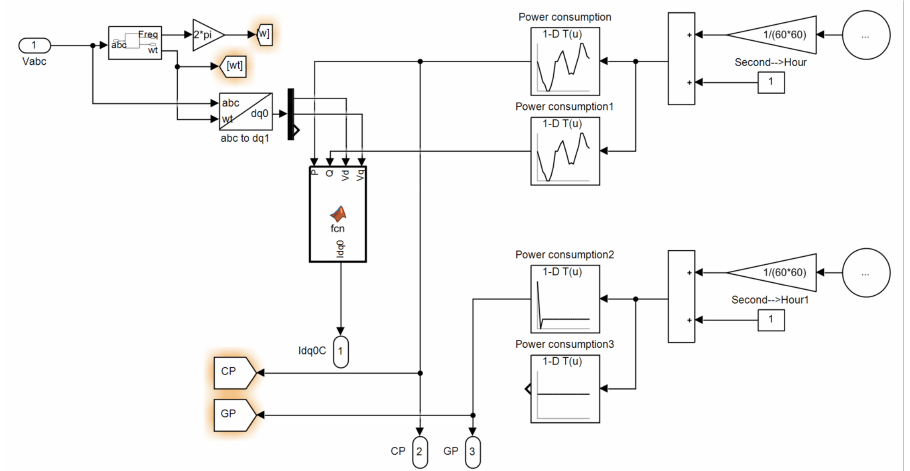
Figure 6. Household